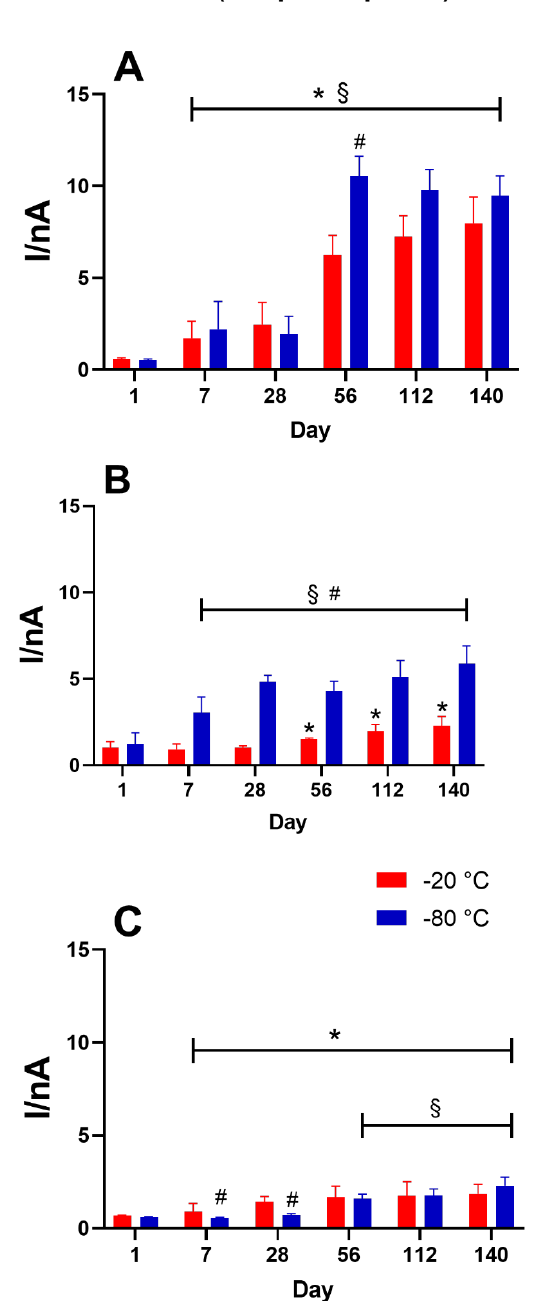
Figure 6. Graph describing variations in the AA 500 µM response in different biosensor groups: control (Pt c /PPD/PEI(1%) 2 /GlutOx 5 ; Panel ( A )), glycerol-loading group (Pt c /PPD/PEI(1%) 2 /GlutOx 5 /GLY(1%); Panel B )) and triethylene glycol-group (Pt c /PPD/PEI(1%) 2 /GlutOx 5 /TEG(1%); Panel ( C )) over a range of 140 days when stored at − 20 ◦ C (red bars) and − 80 ◦ C (blue bars). The subscript numbers represent the number of deposition steps, while the brackets report the concentrations of the component. Pt c : Pt cylinder 1 mm long, 125 µ m in diameter; GluOx: L-glutamate oxidase; PPD: poly-ortho-phenylenediamine; PEI: polyethylene-imine; GLY: glycerol; TEG: triethylene glycol. Data are expressed as the mean ± SEM.* p < 0.05 − 20 ◦ C data vs. corresponding Day 1 data; § p < 0.05 − 80 ◦ C data vs. corresponding Day 1 data; # p < 0.05 vs. − 20 ◦